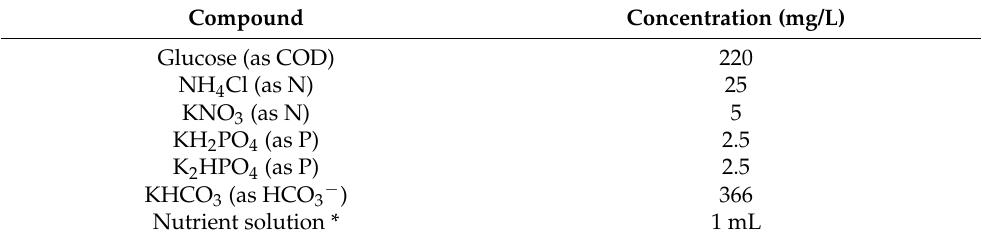
Table 1. Compositions of the compounds in the synthetic